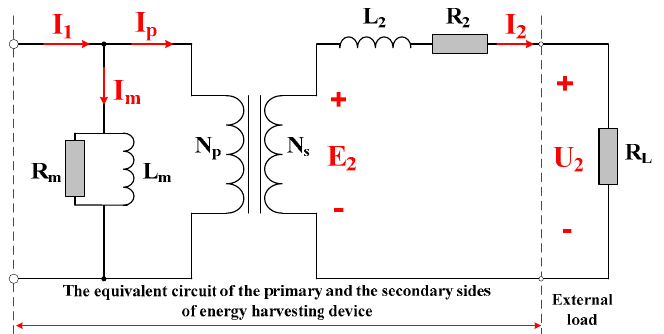
Figure 3. The equivalent circuit of the energy harvesting device.